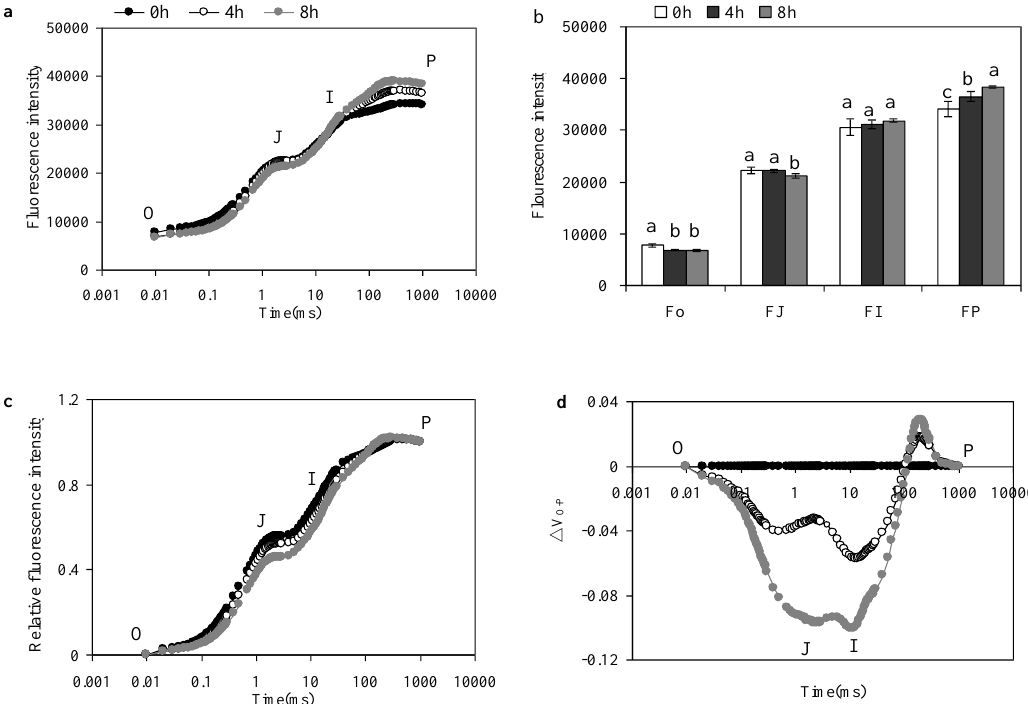
Figure 5. Effects of Chlorophyll A Fluorescence Transient. ( a ) OJIP transmission, ( b ) fluorescence intensity at points O, J, I, and P, ( c ) standardized OJIP transmission, ( d ) standardized OJIP transmission and CK in leaves of mulberry seedlings exposure to 4 µ L · L − 1 NO 2 for 0 h, 4 h (4 h · d − 1 , for one day), and 8 h (4 h · d − 1 , for 2 days). Date represent means of four plants ± standard deviations. Different lowercase letters for the same parameter indicate significant differences among different treatments at p < 0.05 levels.